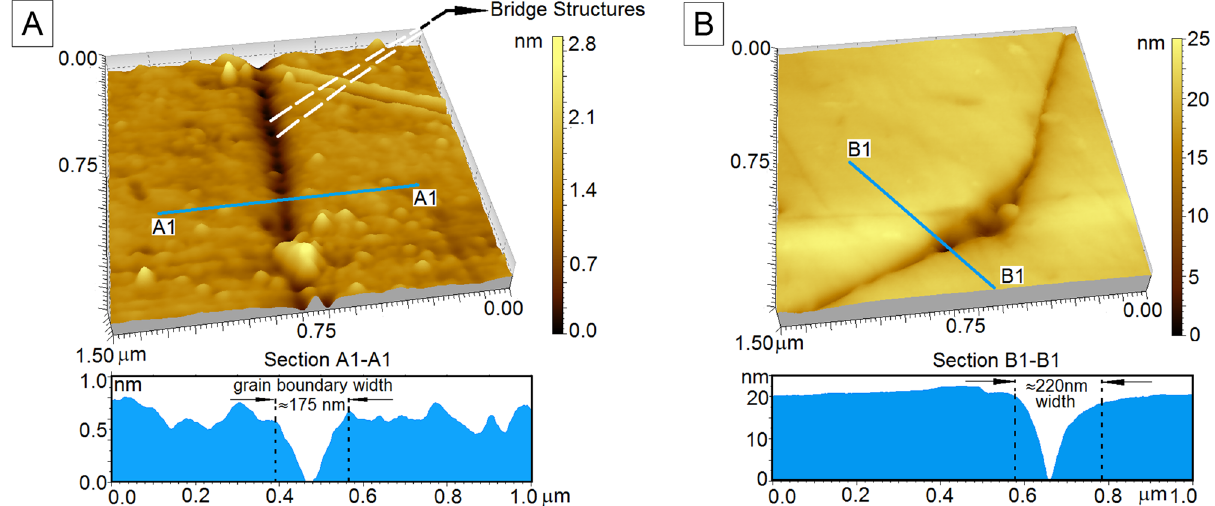
Figure 2. AFM scan images of two representative quartzite samples generated using PicoImage Basic Rendering Software (produced by Digital Surf), that comes integrated with Agilent PicoView Software (version 1.14.4, Agilent Technologies) URL:https:// www. keysi ght. com/ in/ en/ lib/ softw are- detail/ instr ument- firmw are- softw are/ for- your- conve nience- you- can- now- downl oad- picov iew- and- pico- image- softw are- for- your- afm- 22822 56. html. Depth profiles are shown below each scan image. Varying shades of yellow describe the surface elevation within each scan image; widths have been measured along the dotted lines in black which mark the inflection points. ( A ) Straight segment of a boundary within a quartzite deformed under granulite facies conditions (RN 235). Periodically arranged bridges, perpendicular to the length of the boundary are clearly observable. A polishing-induced scratch is visible in the top right corner of the image, which is slightly elevated with respect to the plane of the thin-section ( B ) Junction of two boundary segments within a quartzite deformed under amphibolite facies conditions (RN 36). The width of the junction is significantly larger than the individual boundary segments. Bridge structures are not apparent in this image. Very fine surficial imperfections are visible as linear features cutting across the pore at the junction of the boundary